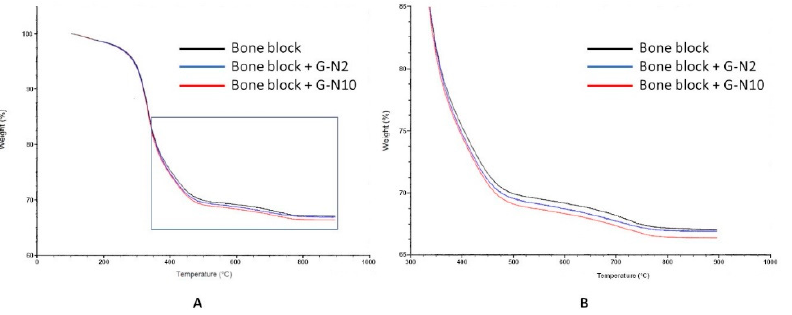
Figure 3. Thermogravimetric analysis (TGA) analysis of an uncoated bone block (black line) and bone blocks coated with G-N at concentrations of 2 (blue line) and 10 μ g/ml (red line). ( B ) is the enlargement of the squared spectra of ( A ).